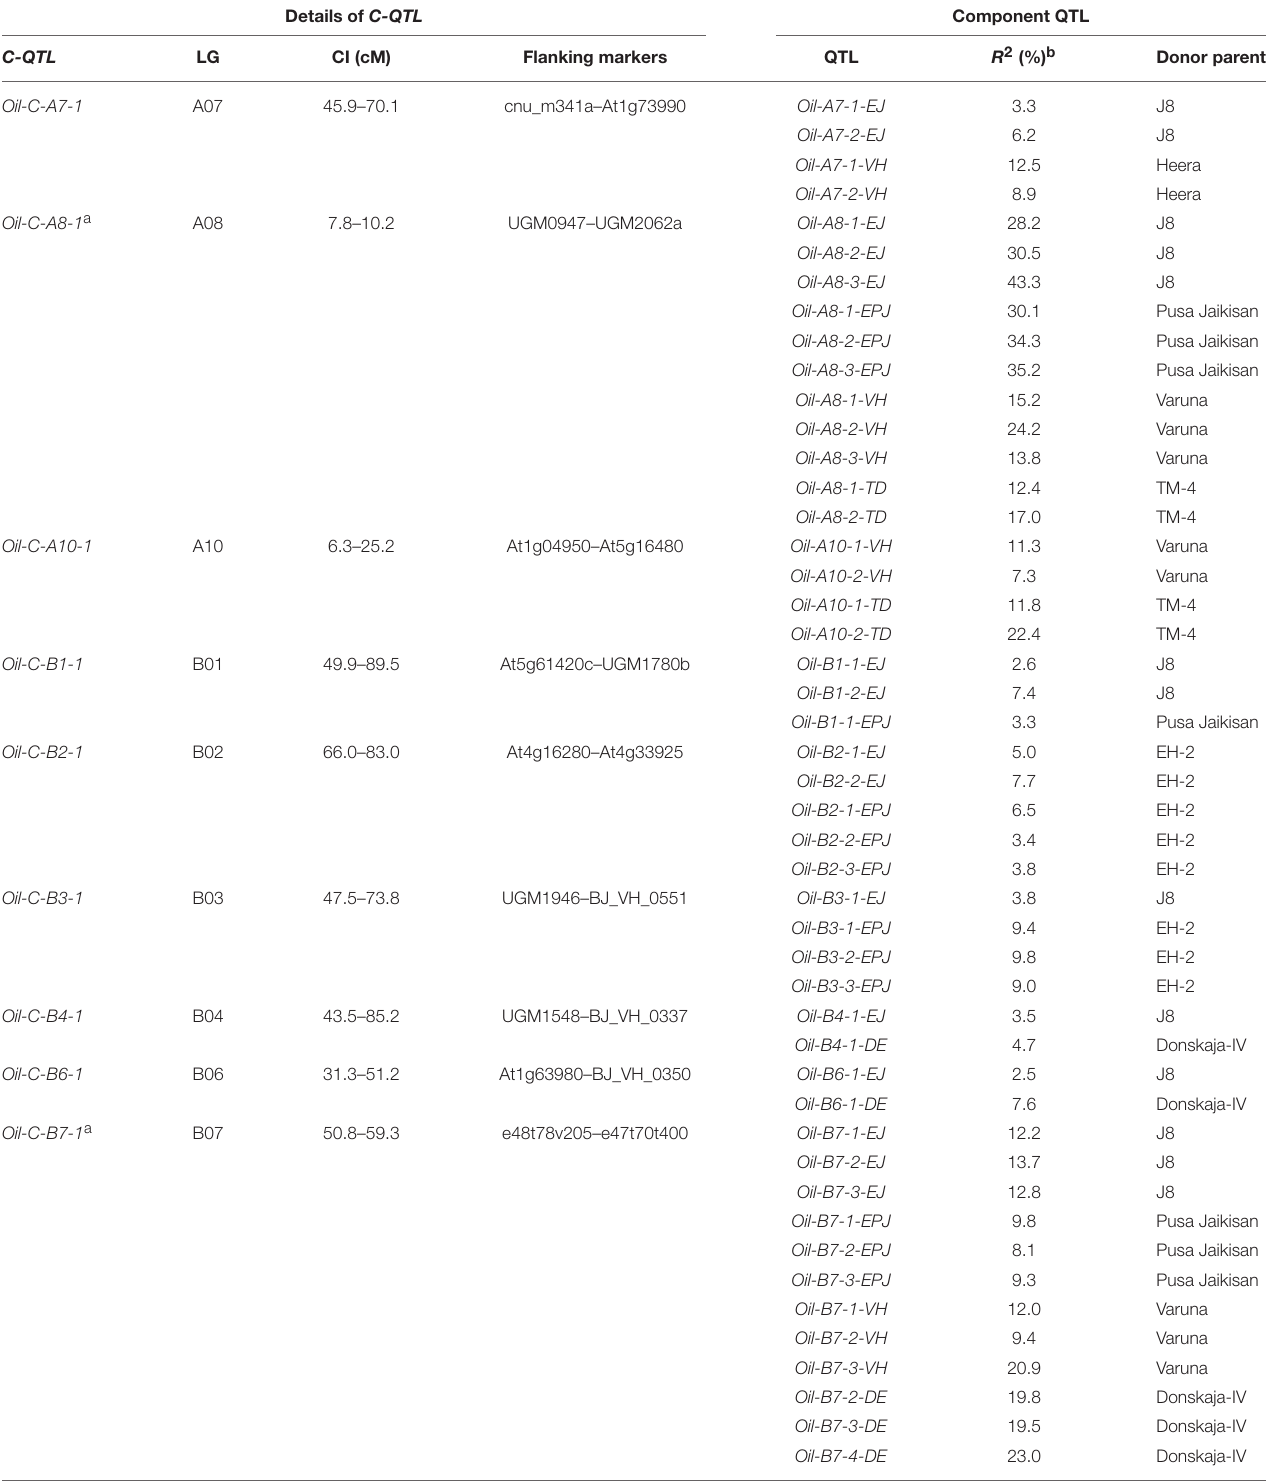
TABLE 4 | Details of consensus QTL ( Oil-C ) detected by merging the QTL data of five SE populations (EJ8 A8B7 , EPJ A8B7 , VH A8B7 , DE B7 , and TD A8 ) through QTL